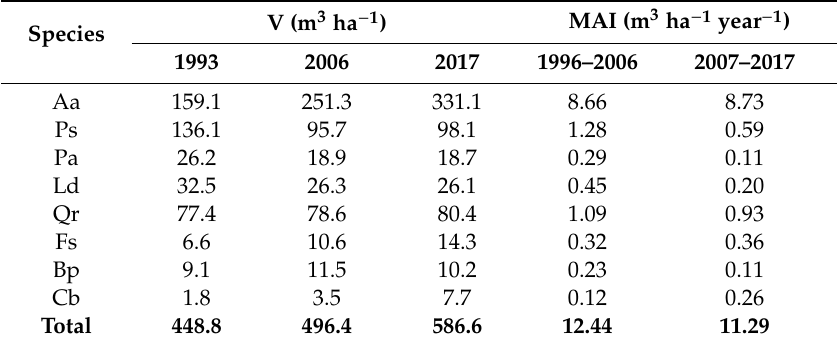
Table 3. Growing stock (V) and mean annual volume increment (MAI) by tree species in the multispecies, uneven-aged forest over 24 years.